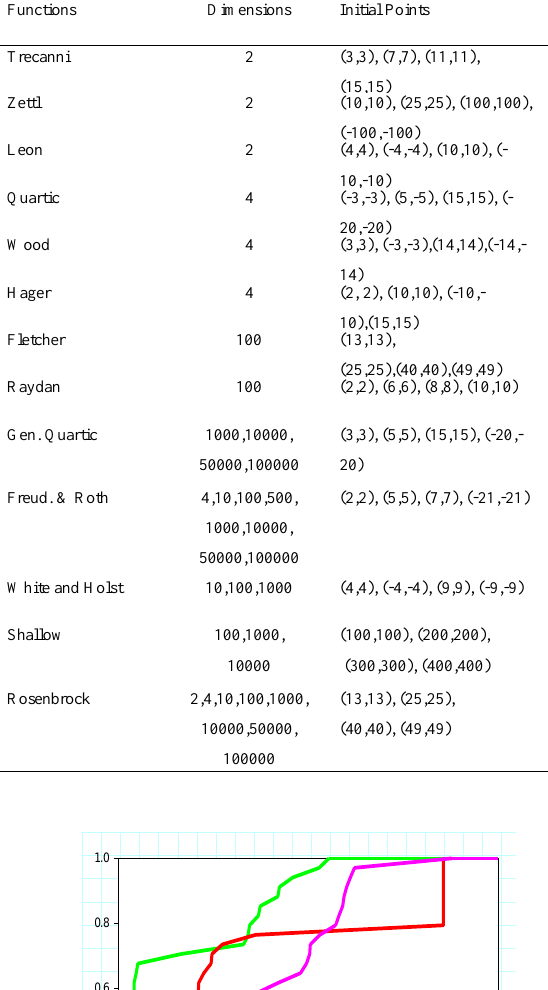
Figure 3. Performance outline based on CPU